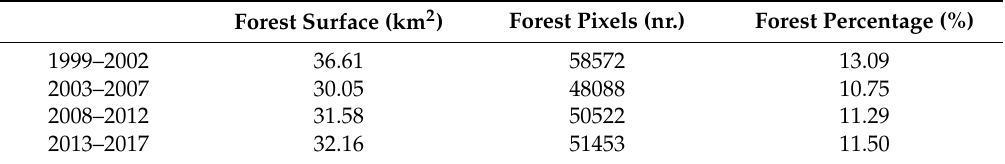
Figure 5. Forest area trend for indicator 15.1.1 in the canton of Geneva, estimated by the forest detection algorithm from 1999 to 2017. Table 2. Forest surface absolute values for the canton of Geneva.